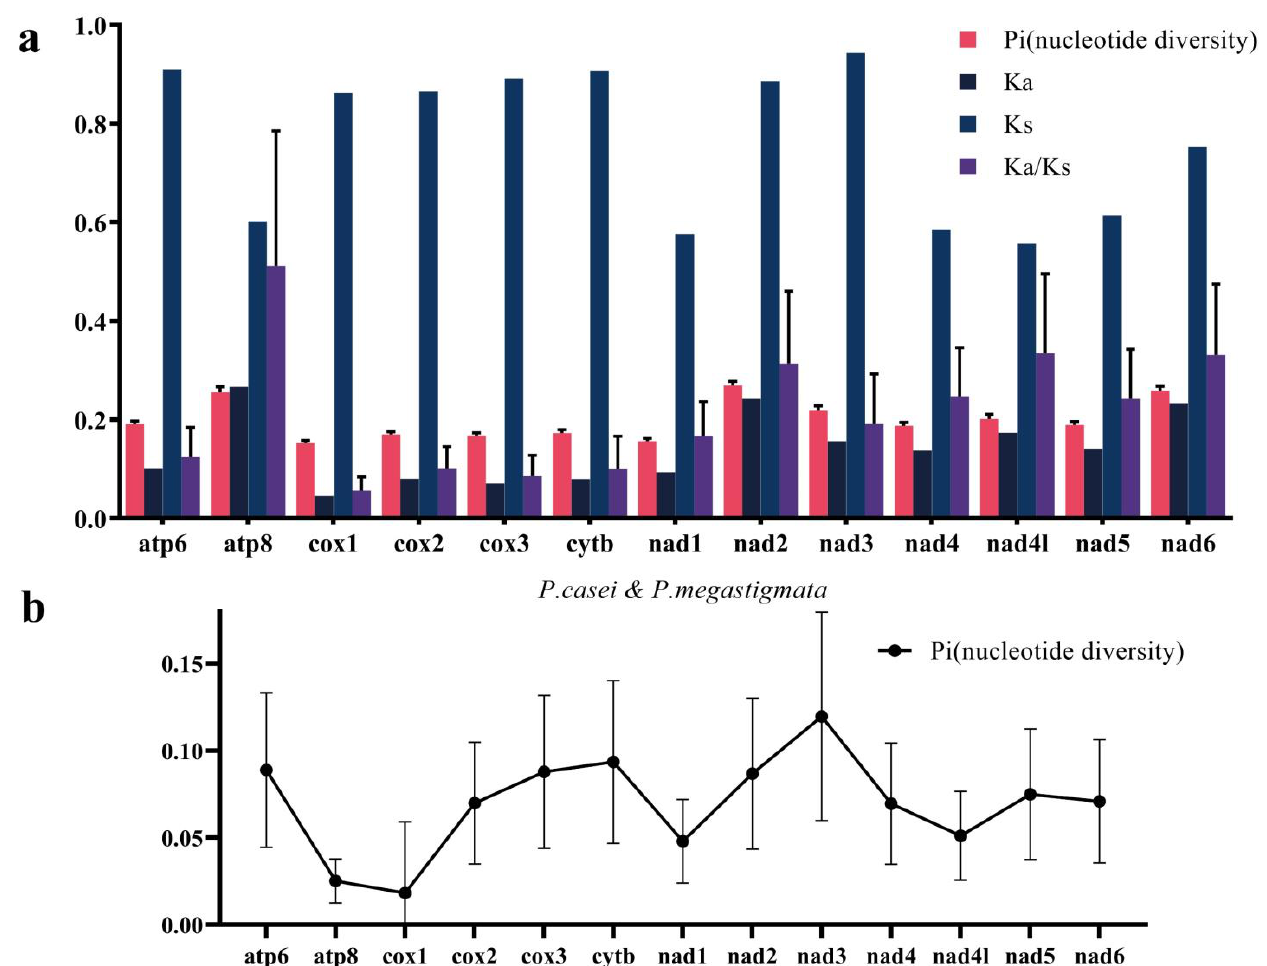
Figure 3. ( a ) Nucleotide diversity (Pi) values of P. casei and P. megastigmata PCGs; ( b ) Pi values and Ka/Ks values of PCGs in the mt genomes of 26 species.